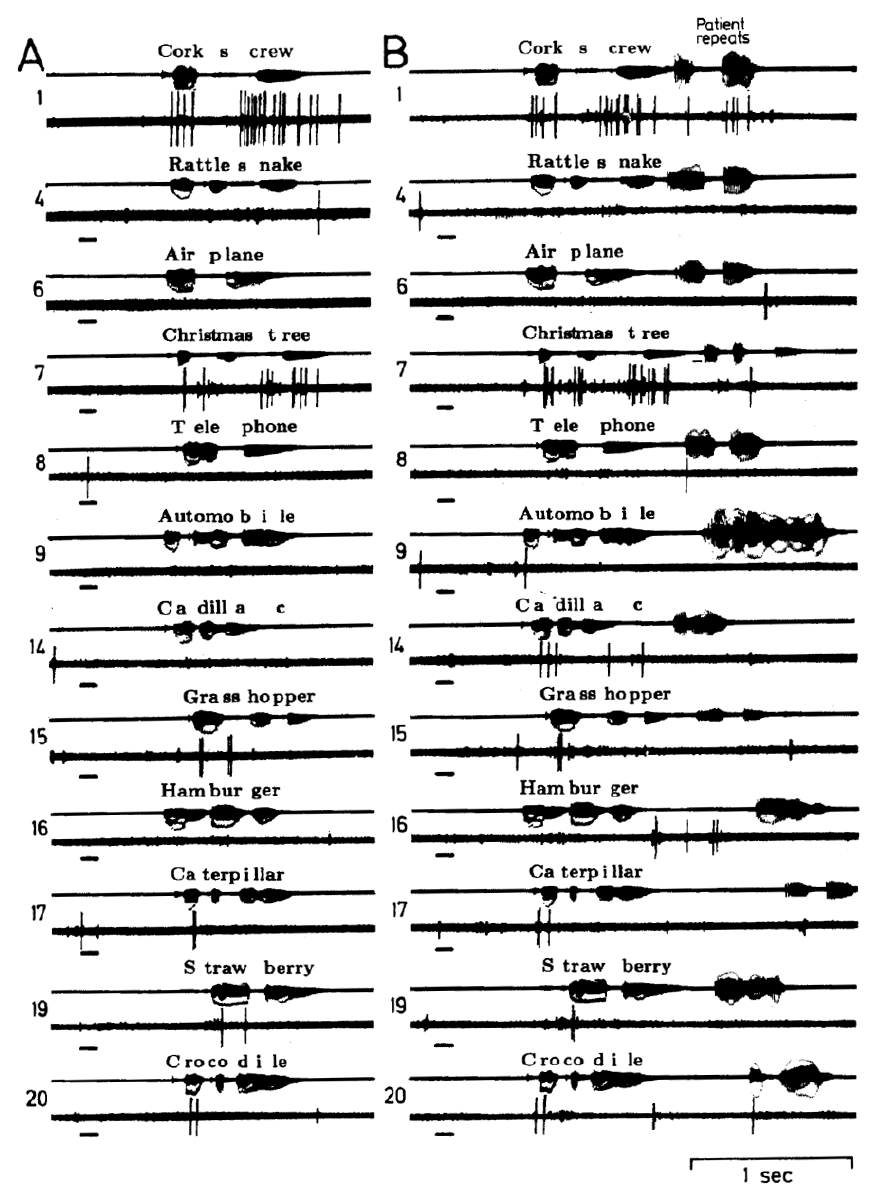
Figure 2. Single neuron activity recorded from right superior temporal gyrus during an auditory language task, listening ( A ) and listening and repeating ( B ) the same 20 words. The short bar to the left in each sample is a 1000 Hz tone. The patient’s overt correct repeating of the word during B is the activity on the far right of the audio channel, the remainder reflects the open field presentation of the words from an audio tape. This neuron appears to have the same patterns of activity during the two sample of listening to words 1, 7, 15, 17, 19 and 20 and an absence of activity during both samples of listening to the other words. This pattern was thought to reflect responses to specific phoneme categories. There is little to no activity in response to the tone or with overt repeating. Adapted from